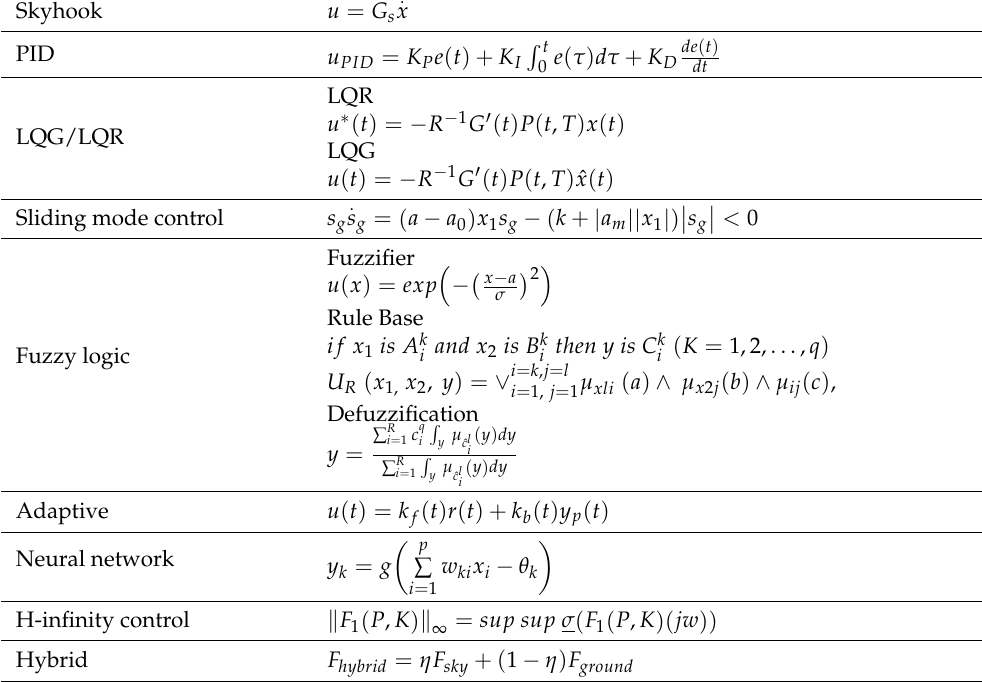
Table 2. Defining equation of the